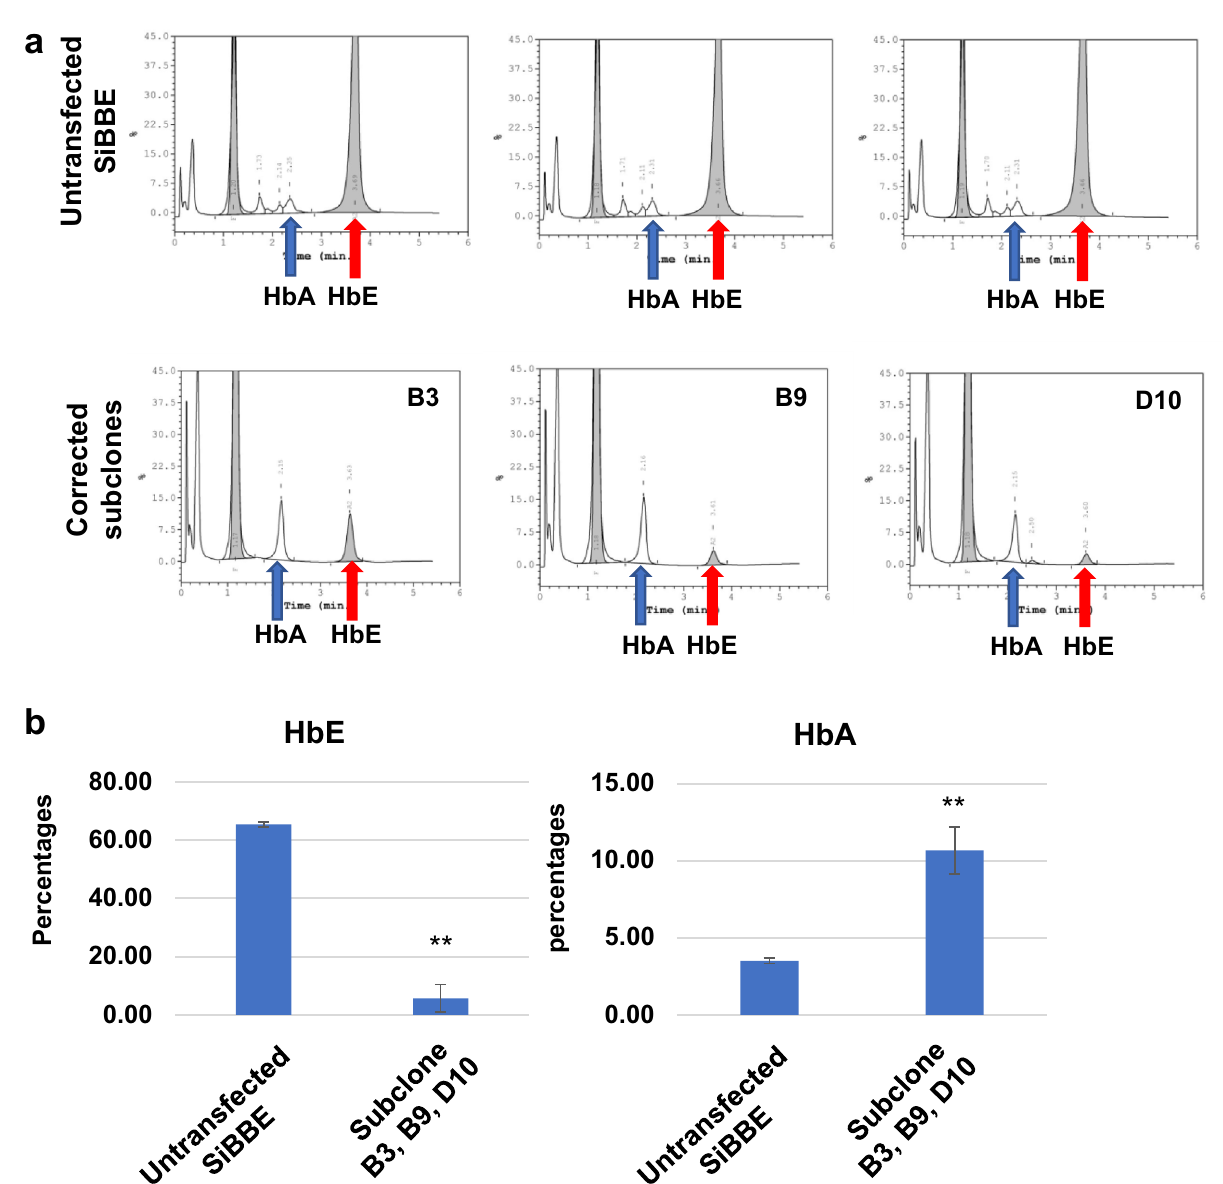
Figure 4. Haemoglobin expression of the HbE-corrected SiBBE cells. ( a ) HPLC traces showing HbA and HbE levels in the three HbE-corrected subclones (B3, B9 and D10) (lower panel) and untransfected SiBBE cells (upper panel). ( b ) Percentage of HbA and HbE expression in the HbE-corrected SiBBE subclones and the untransfected SiBBE cells ** p value < 0.01, two-tailed